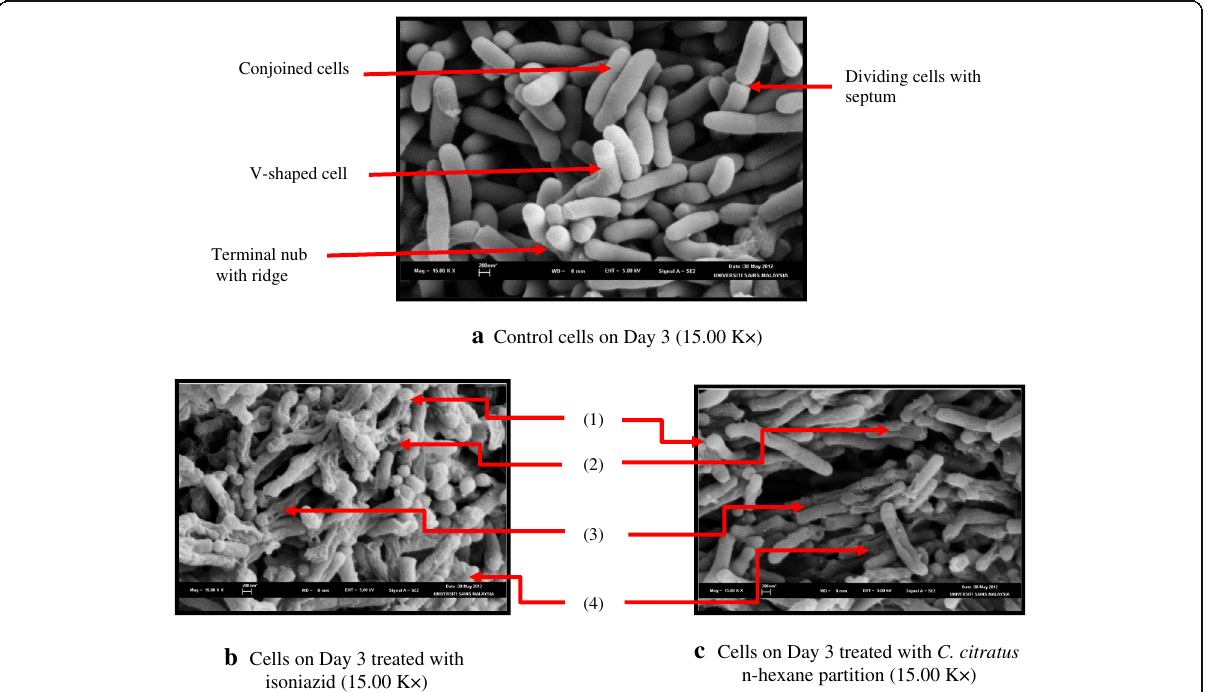
Fig. 4 a - c Scanning electron microscopy observation of the cellular integrity of Mycobacterium tuberculosis H37Rv. (1) Bulges at cell poles, (2) Hollow shells, (3) Holes and dents on cell surface, (4) Amorphous mass of cell debris with web-like